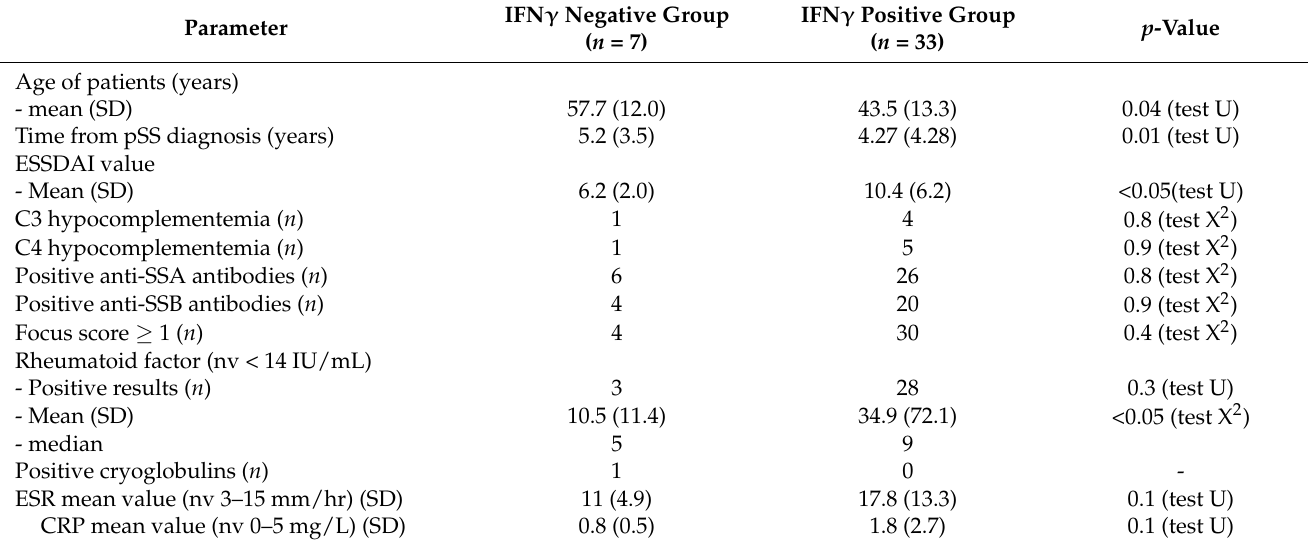
Table 1. Characteristics of pSS patients with positive and negative IFN γ in peripheral blood.